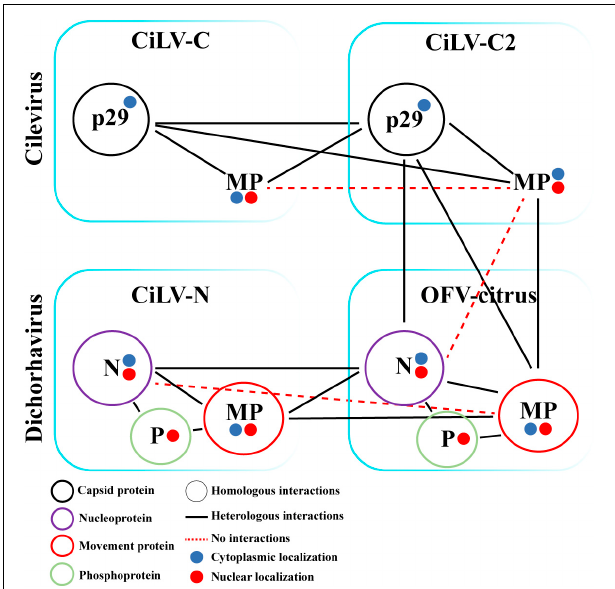
FIGURE 8 | Schematic diagram of the suggested viral protein interaction and localization maps for the cileviruses (CiLV-C and CiLV-C2) and dichorhaviruses (CiLV-N and OFV-citrus) indicated proteins. The scheme indicates the suggested dimeric protein interactions as well as heterologous interactions between proteins of viral species of the same genus and between different genera associated with the citrus leprosis photosystem. Self-interactions are indicated by a color circle specific to each protein. The circles filled with blue or red indicate the cytoplasmatic or nuclear protein localization, respectively. Circularized acronyms indicate positive homologous interactions. Black lines indicate positive heterologous interactions, while red dotted lines indicate lack of positive